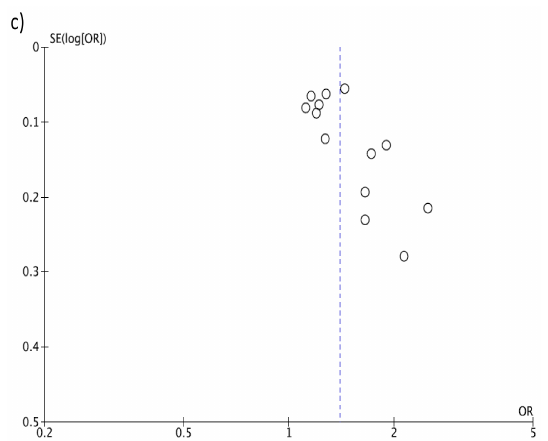
Figure 3. Funnel plots for colorectal cancer risk of the highest versus lowest (reference) category of Dietary Inflammatory Index (DII): ( a ) case-control, ( b ) prospective, and ( c ) all studies. Table 2. Subgroup analyses of studies reporting risk of colorectal, colon and rectal cancer for the highest versus lowest (reference) category of dietary inflammatory index (DII).